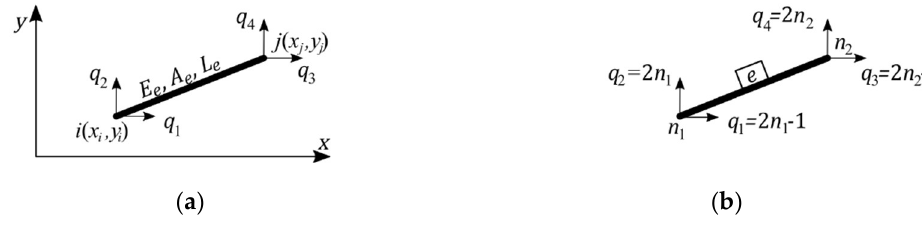
Figure 1. ( a ) Plane truss finite element, ( b ) global degrees of freedom of element 𝑒 .